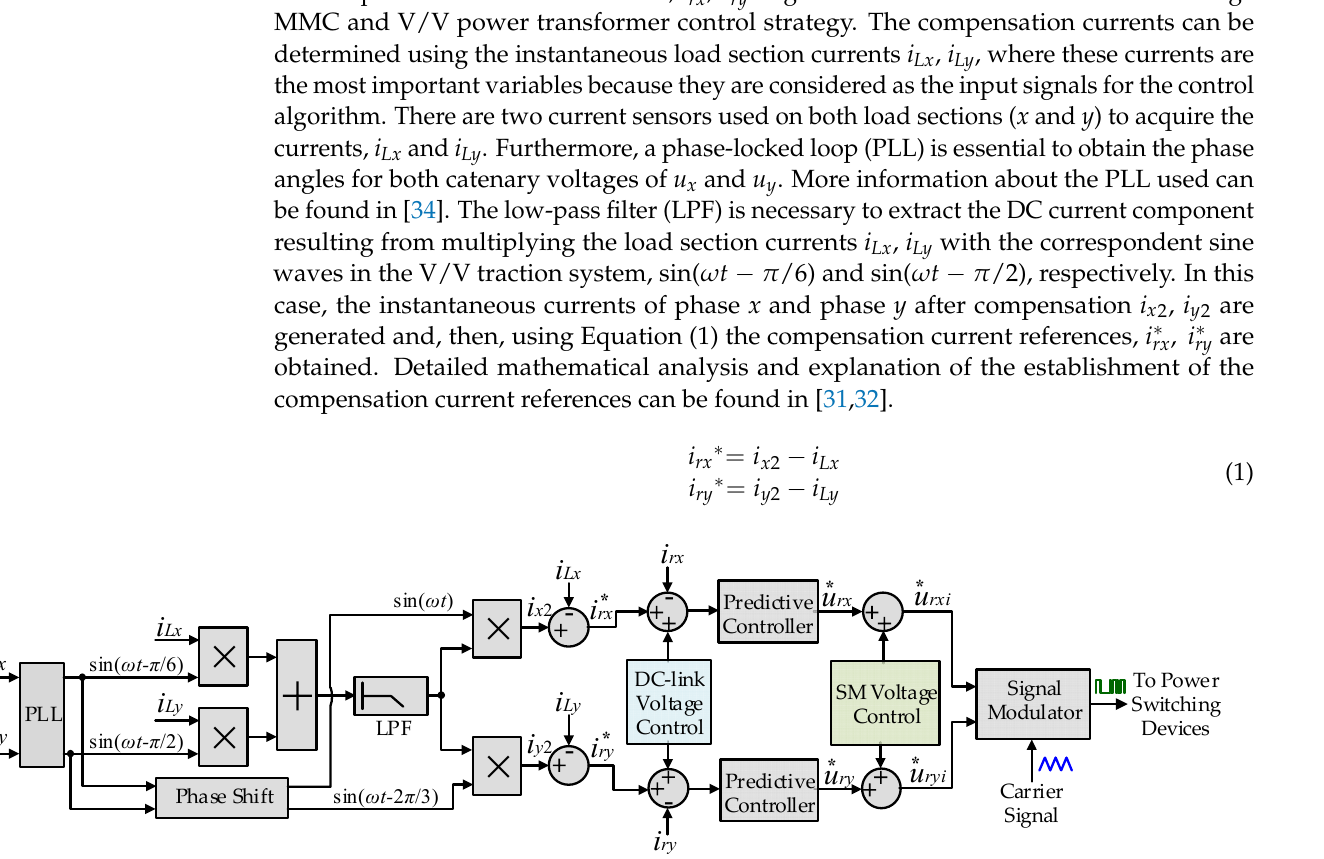
Three-phase Power Grid A B C V/V Power Transformer Step-down Transformer Step-down Transformer Load Section ( y ) Load Section ( x ) LxLy Two-Level Converter ( y ) Two-Level Converter ( x ) Cdc RPC